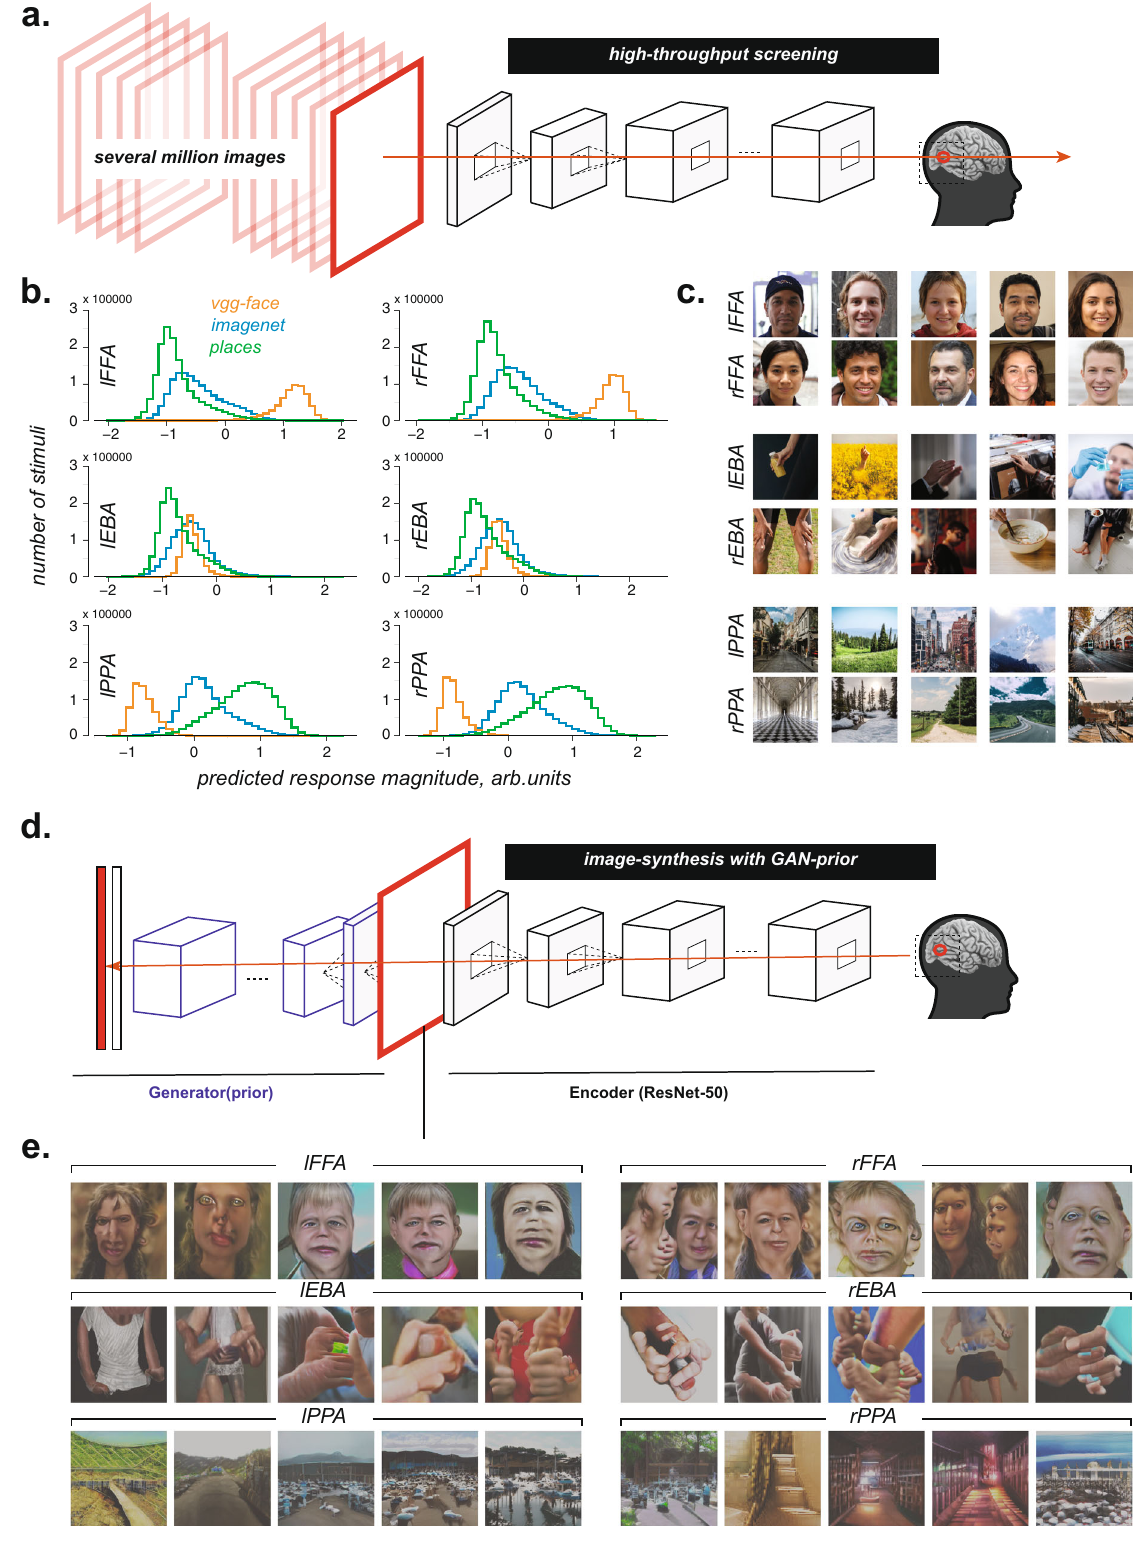
masked images and the predicted responses to generate an ‘ importance map ’ (Fig. 5a). We fi rst applied this method to identify regions of a face stimulus that trigger the response of voxels in the FFA. The overlaid colormaps in Fig. 5b suggest that the response of the FFA